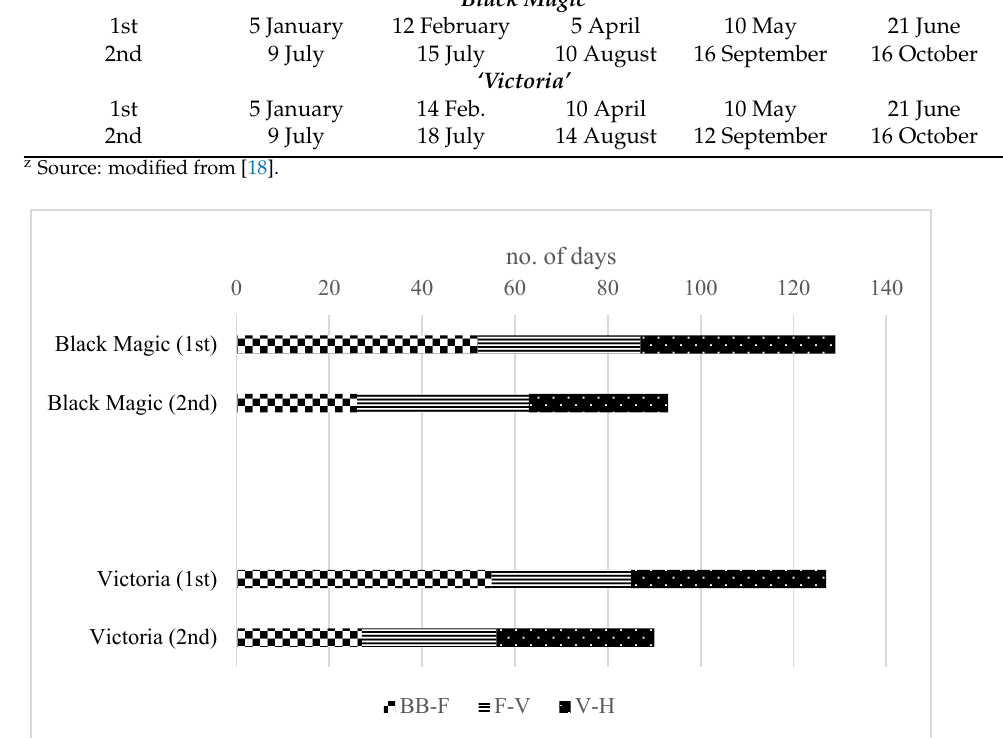
Figure 3. Length of intermediate phenological intervals and total duration (days) of ‘Black Magic’ and ‘Victoria’ berry development during two consecutive cropping cycles in TGSC submitted to